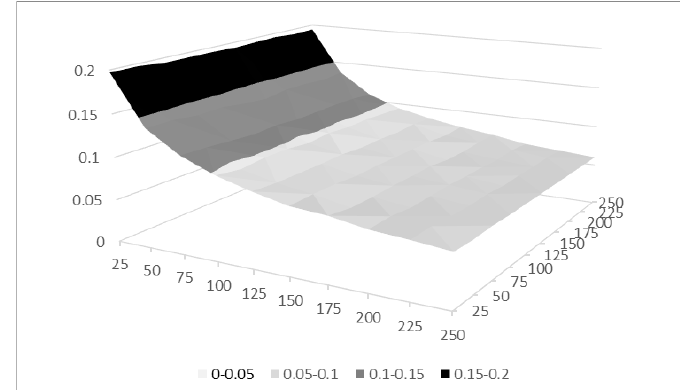
Figure 2. The expectation of the first estimated ergodicity value for different sample sizes N and time point T